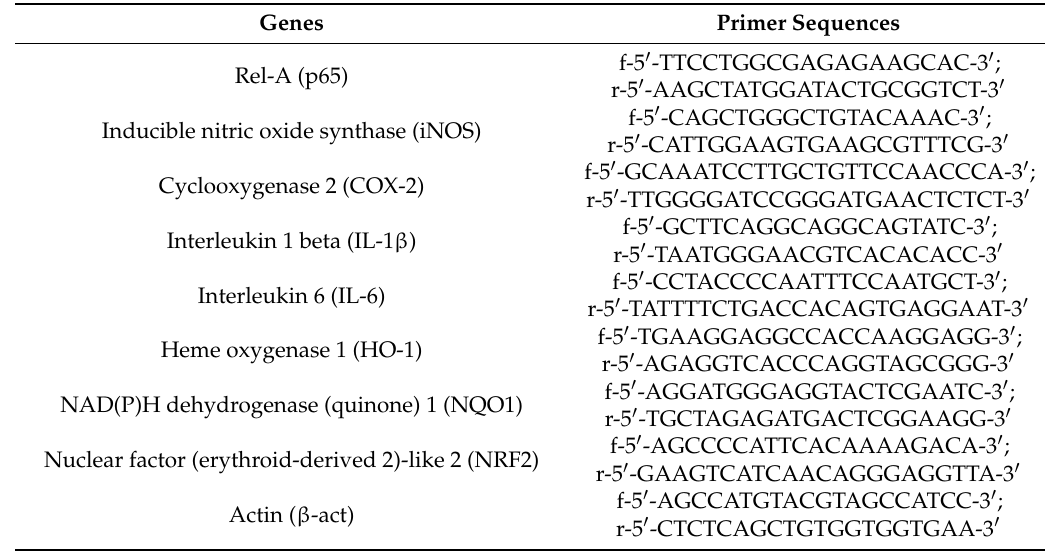
Table 1. Primers used for q-PCR.